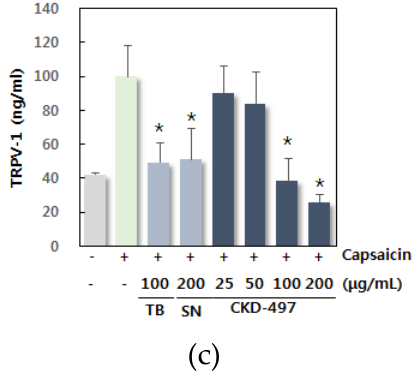
Figure 3. CKD-497 reduced cytokines in TRPV-1-overexpressed BEAS-2B human bronchial epithelial cell. Supernatant of cells after CKD-497 treatment was harvested. The levels of ( a ) IL-8, ( b ) TNF-α, and ( c ) TRPV-1 were measured by ELISA in accordance with the manufacturer’s instructions. Theobromine (TB) and Synatura (SN) were used as positive controls. All experiments were repeated three times and data are expressed as the mean ± SEM ( n = 3). * P < 0.05 compared with the induced group (capsaicin-treated group).